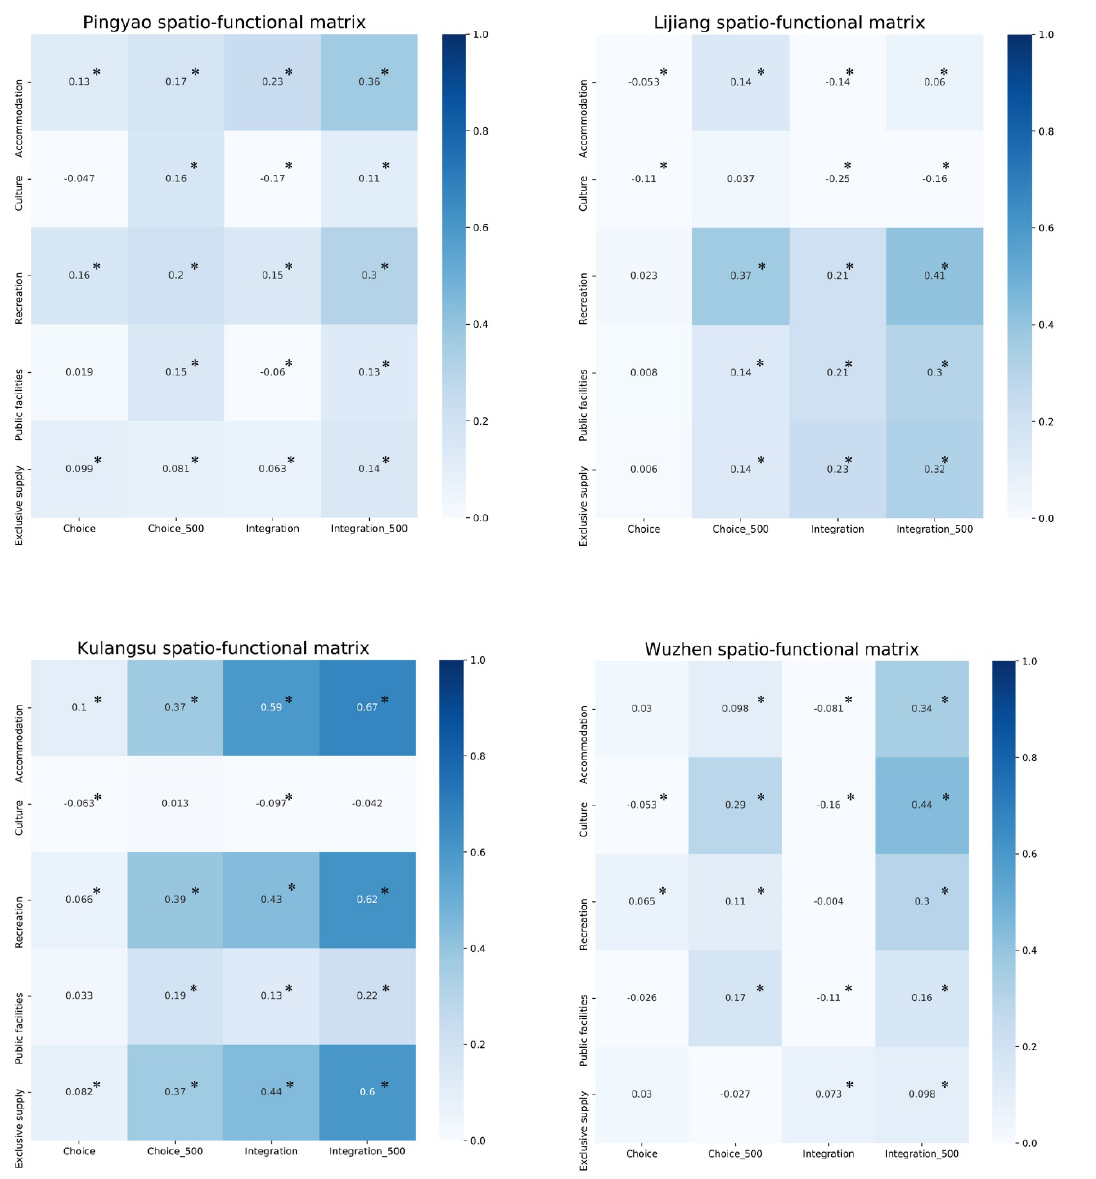
Figure 11. The spatio-functional correlation matrix of the four HCTs where a darker blue colour represents a higher Pearson coefficient value (* correlation is significant at the 0.05 level for 2-tailed).